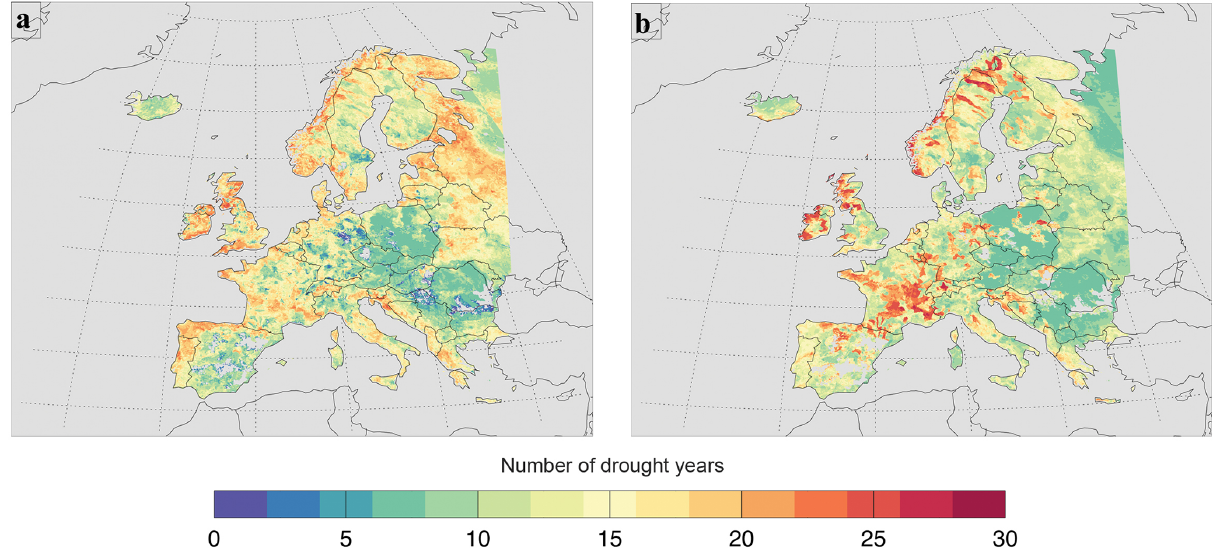
Figure 3. Spatial distribution of the number of drought years derived from drought in runoff (a) and groundwater (b) over the period 1990–2017.